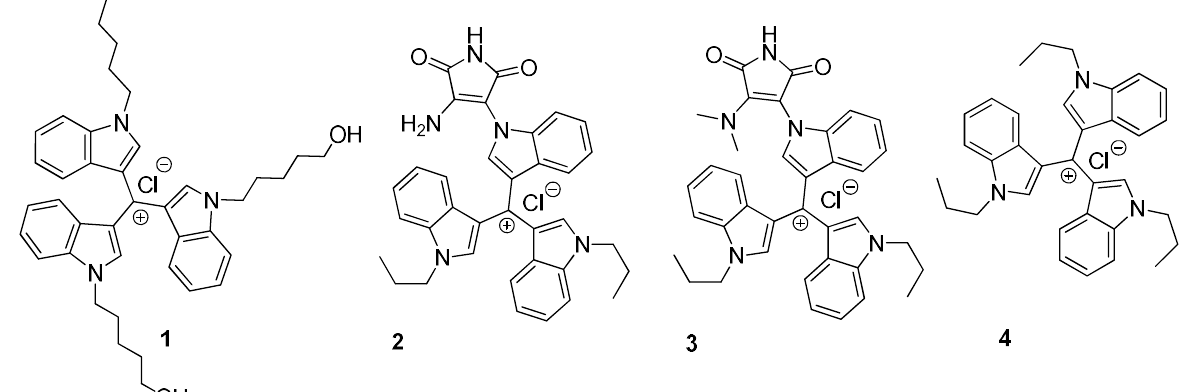
Figure 1. Chemical structures of compounds 1 – 4 .